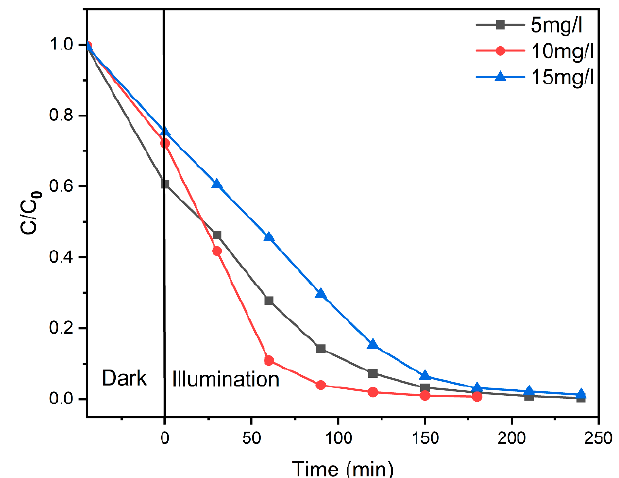
Figure 7. Photocatalytic degradation of MB (10 mg/L) at various catalyst loadings of 40CaO-30B 2 O 3 - 30 V 2 O 5 glass.